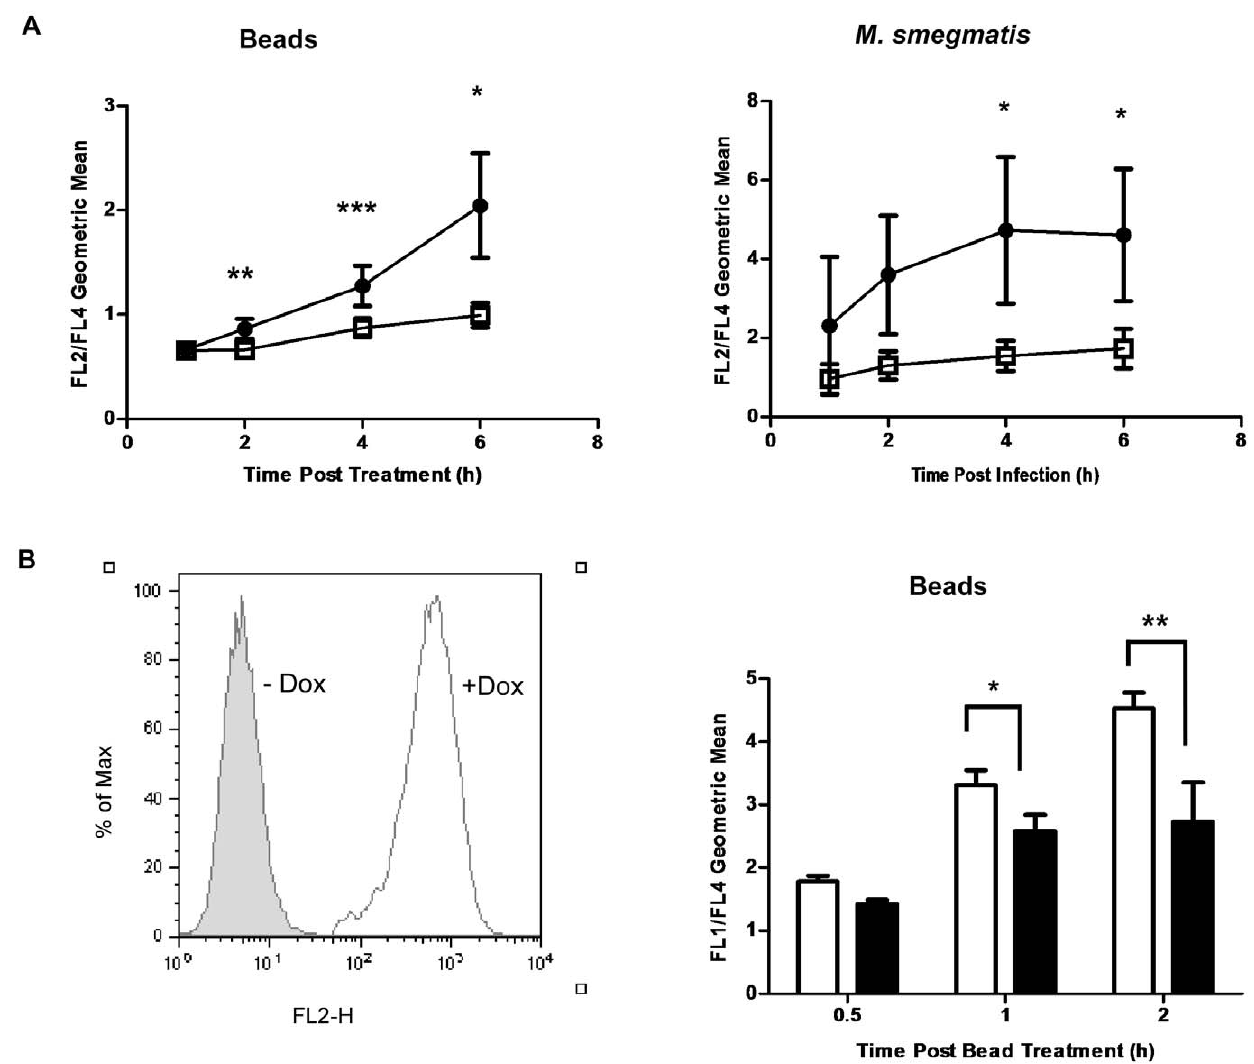
Figure 5. Delivery of the lysosomal enzyme b - galactosidase is impaired in p110 a knockdown cells. A) Knockdown of p110 a results in decreased acquisition of the lysosomal enzyme b - galactosidase by phagosomes containing either BSA coated beads or M. smegmatis. Cells were fed prey that had been previously surface labelled with Alexafluor 633-SE and the fluorescent b -galactosidase substrate, C 12 RG. Cleavage of C 12 RG releases fluorescence which is read in the FL2 channel of the flow cytometer. This was then normalized to the Alexafluor 633 signal (FL4) for phagocytic uptake. Solid circles = control cells, empty squares = p110 a knockdown cells. Timepoints were taken at 1 hour, 2 hours, 4 hours, and 6 hours post bead treatment or infection. *p , 0.05, **p , 0.001, **p , 0.0005. Data are means + / 2 s.e.m., from at least four independent experiments. B) Inducible p110 a knockdown via a distinct shRNA sequence also showed defects in b -galactosidase acquisition. Knockdown was induced by doxycycline treatment prior to experimentation, which also induces expression of TurboRFP which is linked to shRNA production. The histogram on the left shows induction of red fluorescence when cells were given doxycycline. Cells were also fed the green fluorescent b -galactosidase substrate, C 12 FDG, which is read in the FL1 channel. Empty bars = Control cells (no doxycycline induction), Solid bars = Cells induced for p110 a knockdown. *p , 0.05, **p , 0.001. Data are means + / 2 s.e.m. from five independent